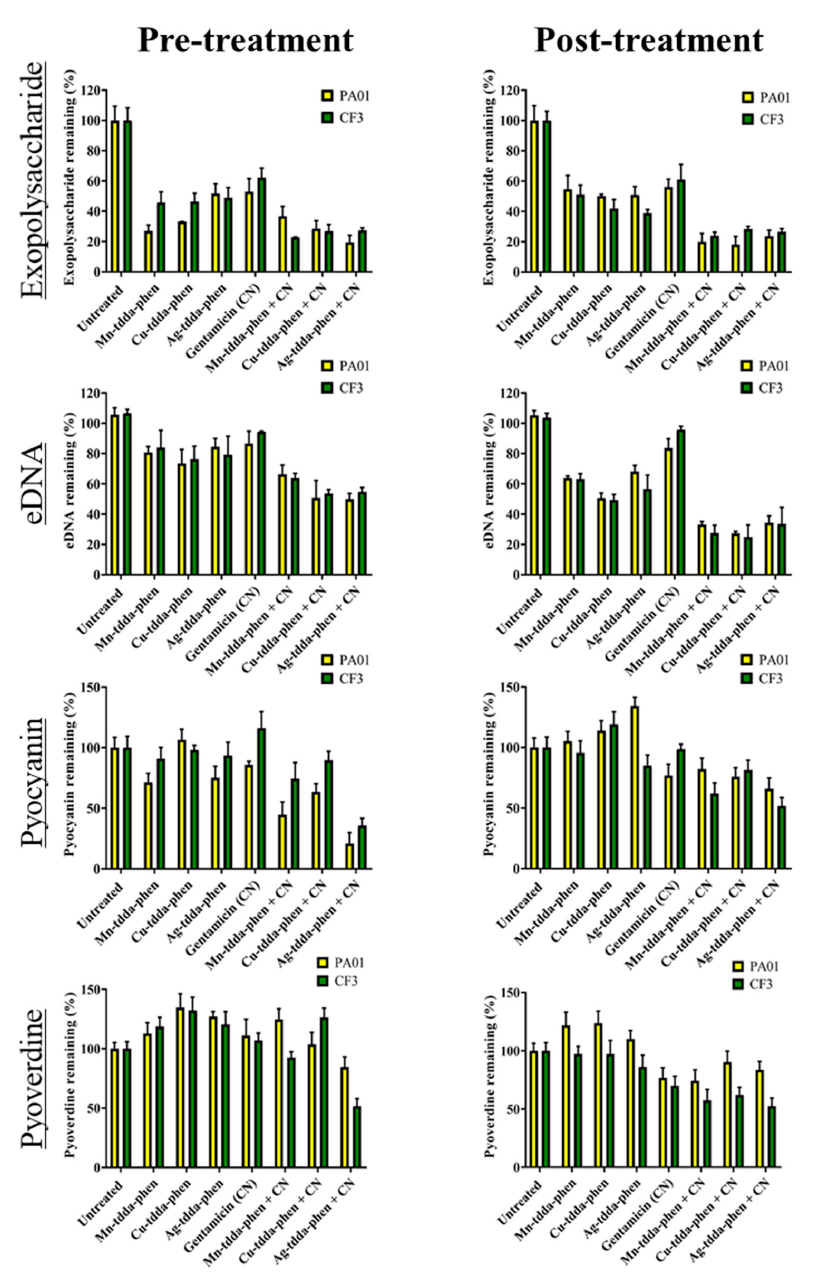
Figure 4. Effects of metal-tdda-phen complexes alone, gentamicin alone, and metal-tdda-phen complexes with gentamicin on both the formation of biofilm (pre-treatment) and reduction of established biofilm (post-treatment) of PAO1 and CF3: The percentages of exopolysaccharide, eDNA, pyocyanin and pyoverdine remaining after treatment (relative to untreated biofilms) are given.